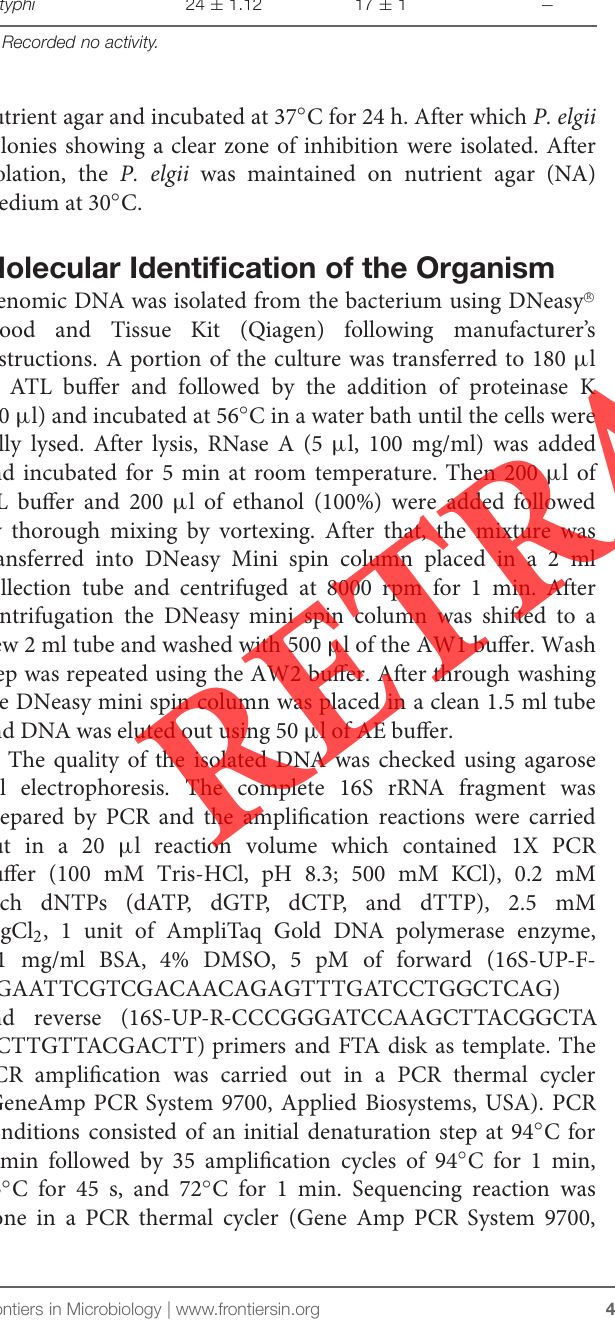
Applied Biosystems, USA) using the Big Dye Terminator